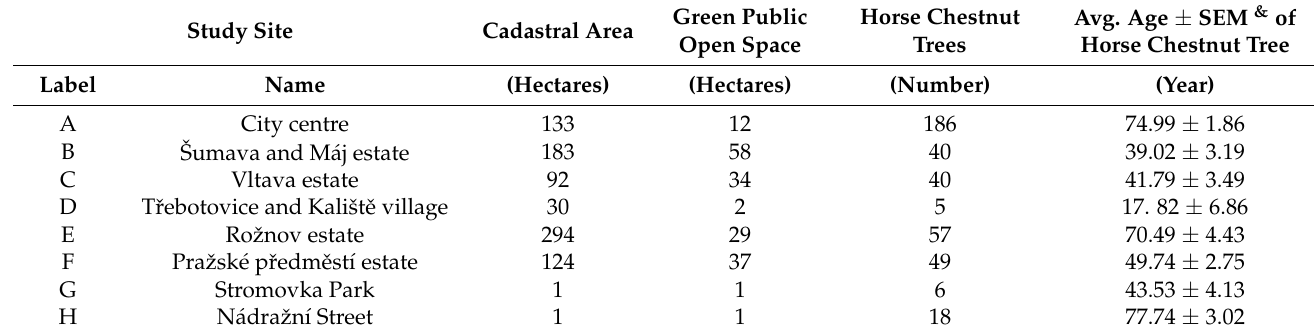
Table 1. Characteristics of the studied